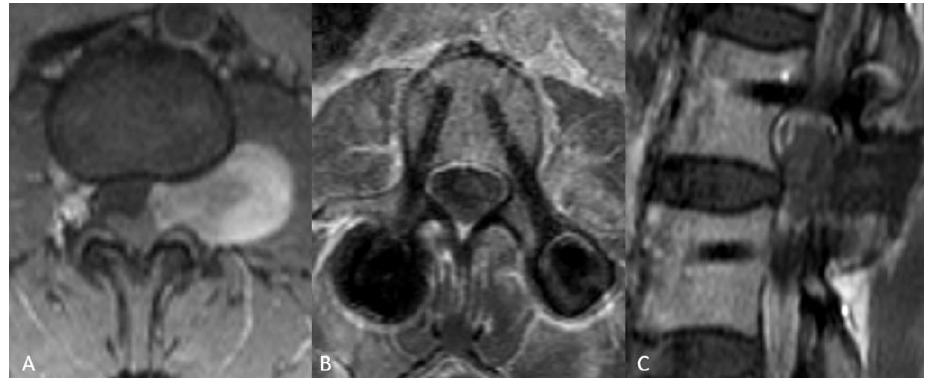
Figure 5. Case example of a 31-year-old female patient with low back pain. MRI showed a contrast enhancing space occupying lesion at L 2 – 3, Eden type 3 ( A ), tumor resection was performed via facetectomy and minimally invasive instrumentation. Postoperative images ( B , C ) show complete tumor resection. Notice the clear images with minimal artefacts due to CFR-PEEK instrumentations. Histology confirmed a grade I schwannoma.